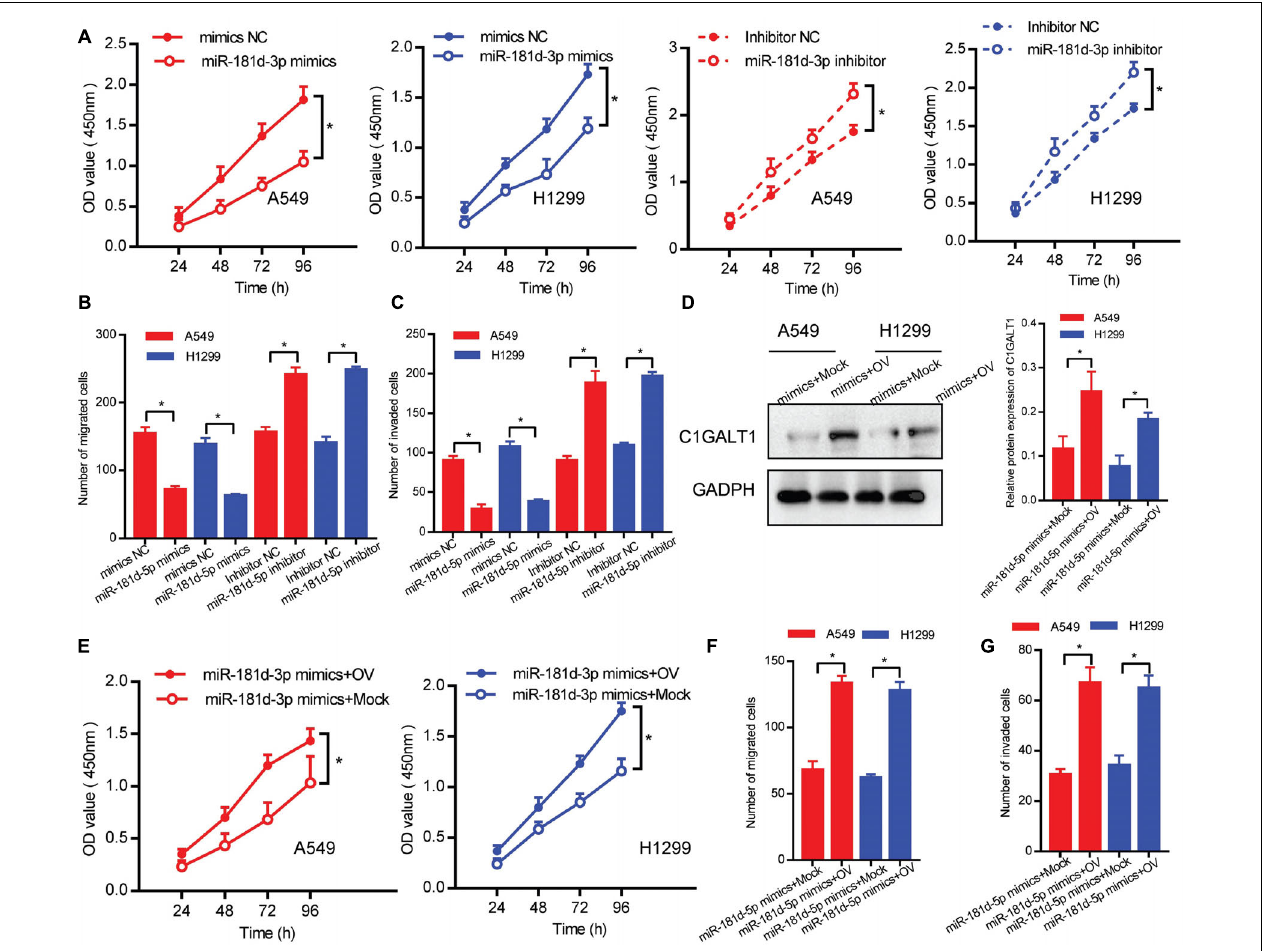
FIGURE 6 | miR-181d-5p functions as a negative regulator of C1GALT1 in LUAD. (A–C) The effect of miR-181d-5p mimics or inhibitor on cell proliferation, migration, and invasion was determined by CCK-8 assay (A) , Transwell migration assay (B) , and Matrigel invasion assay (C) . (D) Western blot analysis of C1GALT1 expression in cells co-transfected with miR-181d-5p mimics and C1GALT1 overexpression plasmid. (E–G) The inhibitory effect of miR-181d-5p mimics on cell proliferation (E) , migration (F) , and invasion (G) were antagonized by overexpression of C1GALT1. Mock, cells transfected with empty plasmid; OV, cells transfected with C1GALT1 overexpression plasmid. Data are expressed as mean ± SD. * p <